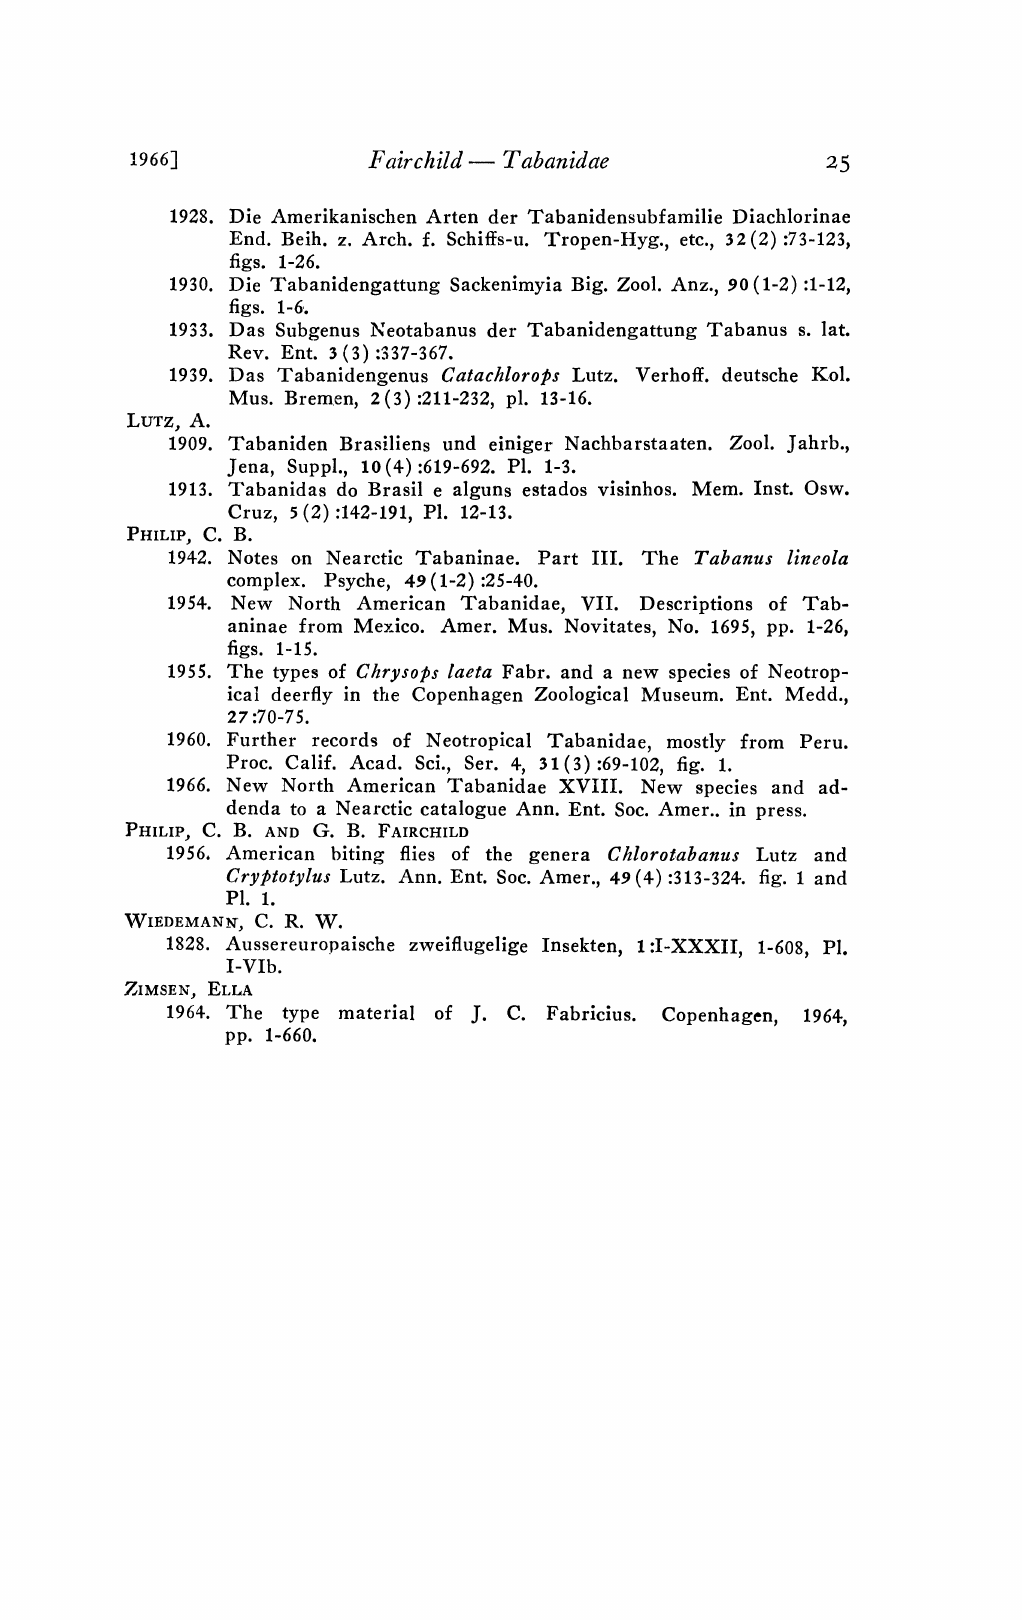
figs. 1-26. 1930. Die Tabanidengattung Sackenimyia Big. Zool. Anz., 90(1-2):1-12, figs. 1-6.. 1933. Das Subgenus Neotabanus der Tabanidengattung Tabanus s.